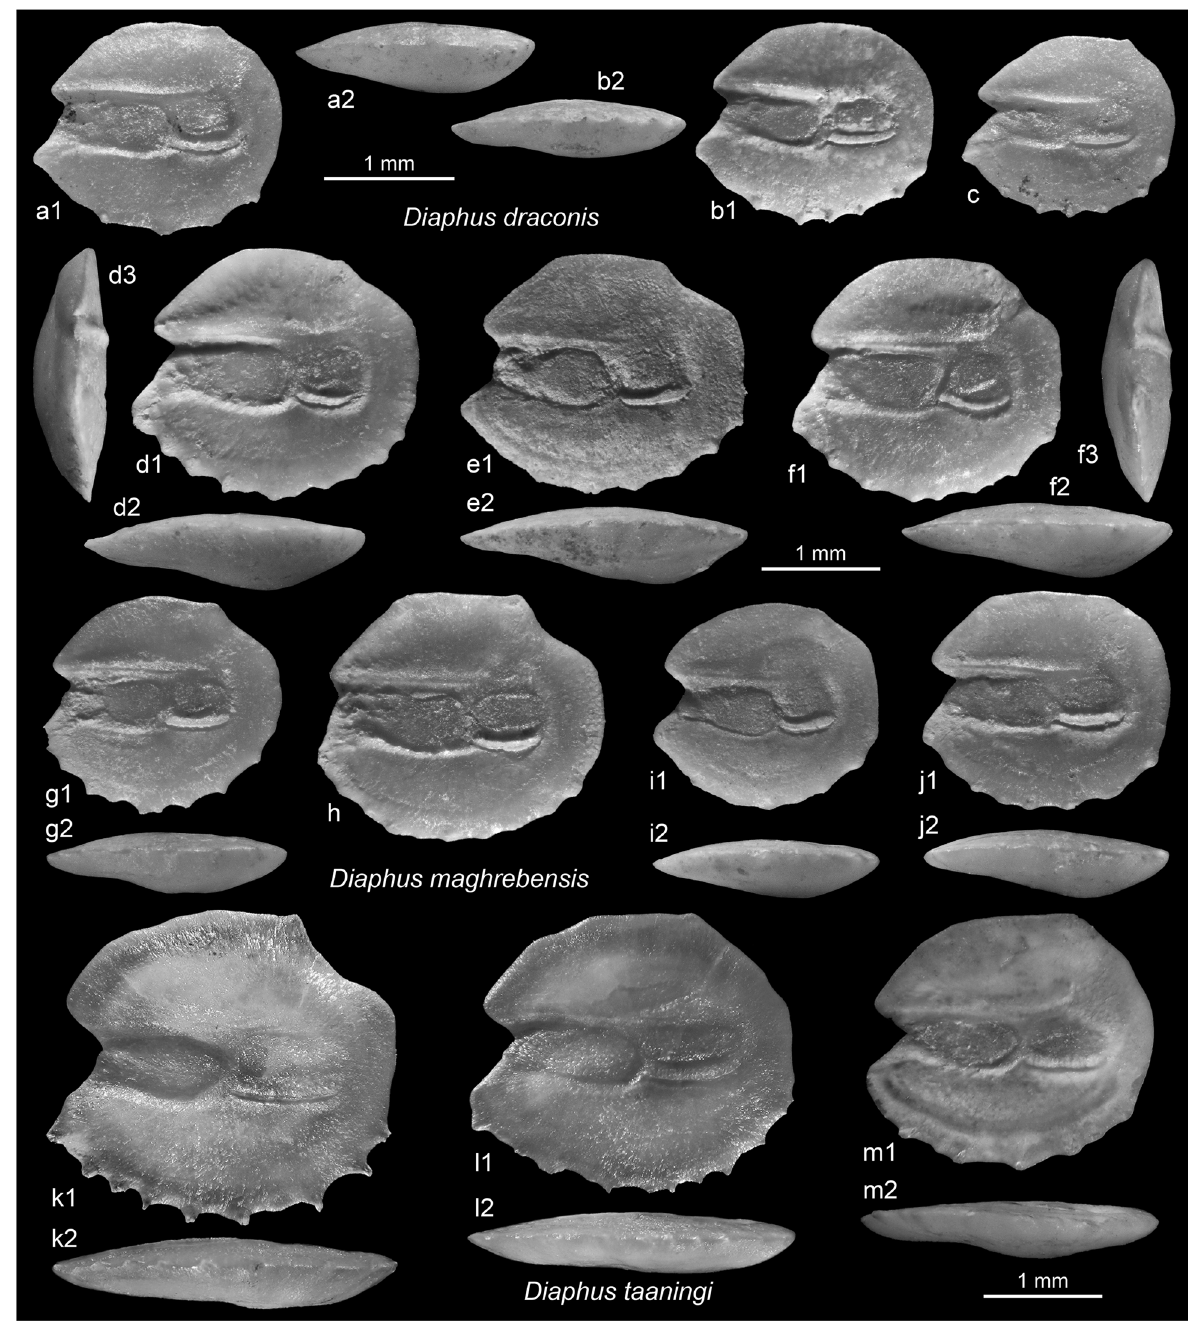
Fig. 13 Myctophidae. a – c Diaphus draconis Schwarzhans, 2013, SMF PO 101.200 ( c reversed), Kef Nsour, Messinian. d – j Diaphus maghrebensis n. sp. f holotype, SMF PO 101.201, Dar bel Hamri, Zanclean, paratypes, h – j SMF PO 101.202 ( h , j reversed), Dar bel Hamri, Zanclean, e SMF PO 101.203 (reversed), Kef Nsour, Messinian, d , g SMF PO 101.204, Sidi Mohamed ech Chleuh, Zanclean. k – m , Diaphus taaningi Norman, 1930, extant, k – l MCZ 150978, 36°17’N, 74°49’W, 13 m refigured from Schwarzhans (2013b), dredge in the Gulf of Guinea, 00°20’S,